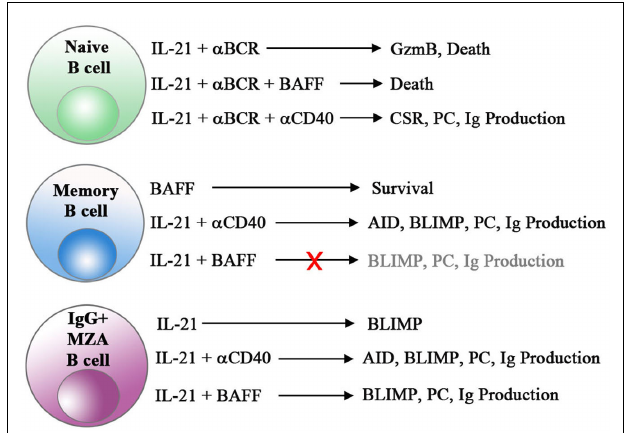
FIGURE 1 | Unique and synergistic effects of IL-21 and BAFF on human B cell subsets. The combination of IL-21 and BCR engagement triggers cell death in naive B cells. CD40 signals, but not BAFF, reverse this cell death in naive B cells and combine with IL-21 to induce class switch recombination (CSR), plasma cell differentiation (PC) and antibody production in all B cell subsets. Importantly, post-switched MZA B cells represent a unique